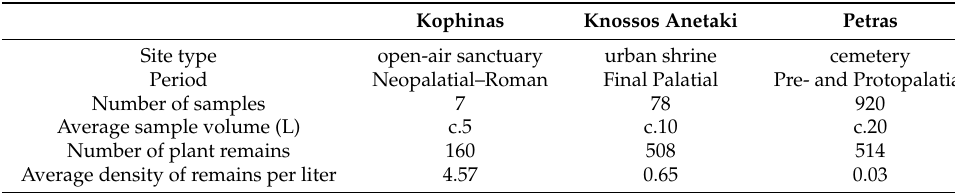
Table 1. Summary of analyzed